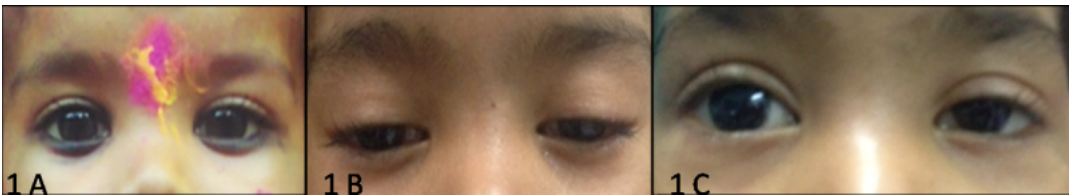
Figure 1: A: External photograph of the patient showing normal upper lid position in both eyes before onset of symptoms. B: External photograph of the patient showing bilateral severe ptosis. C: External photograph of the patient showing marked improvement after starting treatment for myasthenia